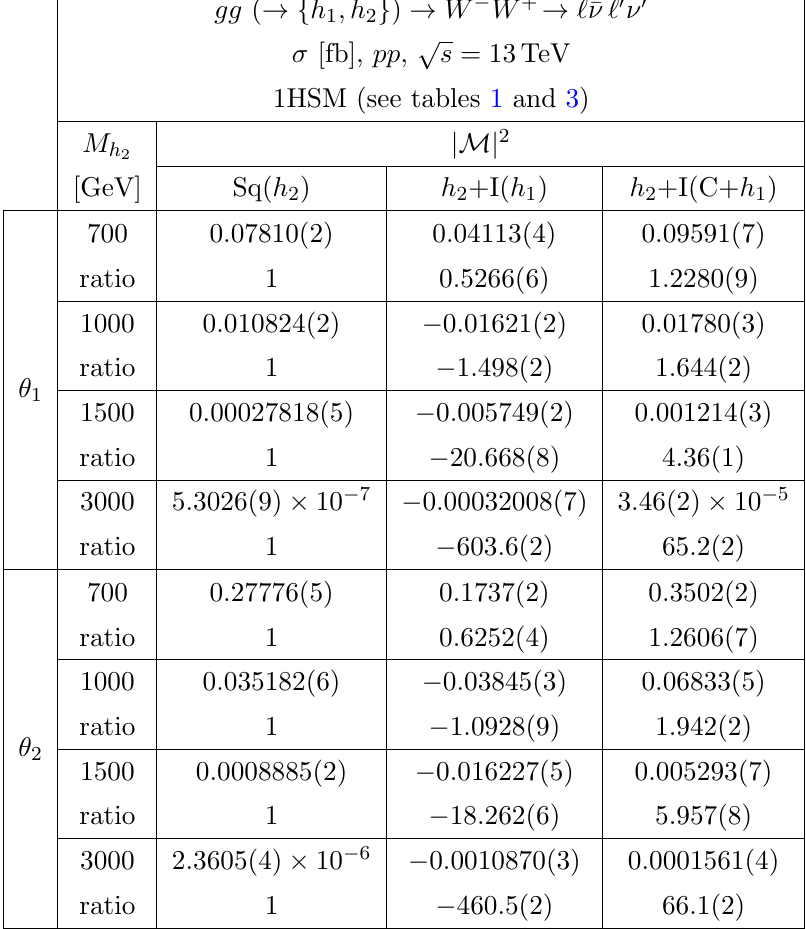
h ; h W (cid:0) W + ‘ (cid:22) (cid:23) (cid:22) ‘ 0 (cid:23) 0 in pp collisions at p s = 13 TeV 1 2 g ) ! ! f !